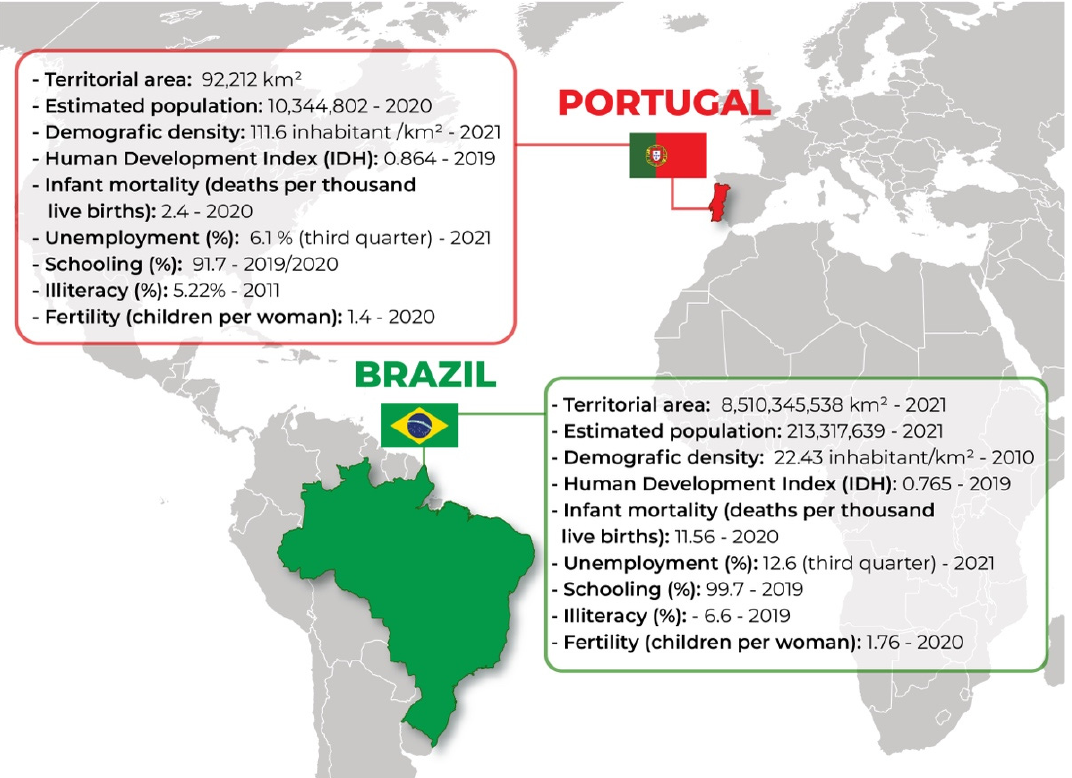
Figure 1. Sociodemographic data from Brazil and Portugal. The map shows socio-economic indicators for each country—Source: authors’ elaboration .